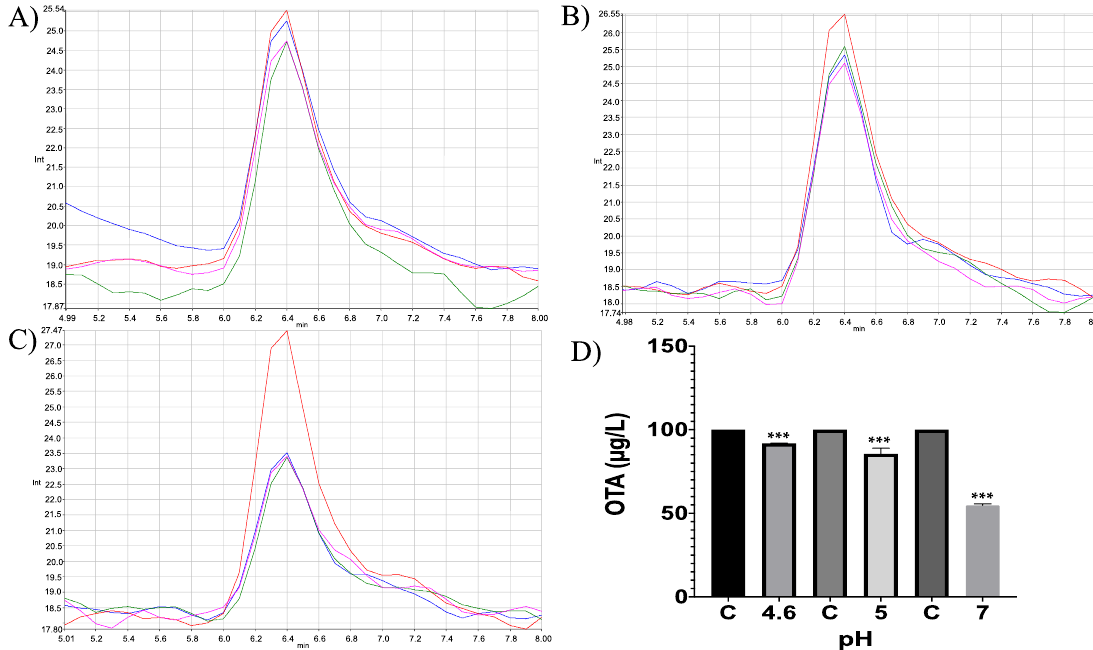
Figure 23. Neutral metalloendopeptidase in vitro experiments. HPLC-fluorescence chromatograms of neutral metalloendopeptidase–OTA in vitro experiments, showing differences in its ability to degrade OTA at different pH conditions and incubated at 41 ◦ C. ( A ) pH 4.6; ( B ). pH 5; ( C ) pH 7; ( D ) Bars showed OTA (µg/L) degradation (8.2, 14.44 and 45.26%) at pH 4.6, 5 and 7, respectively. In all chromatograms the control is represented in red and experimental repetitions are in blue, green and pink. (*** p < 0.0001).